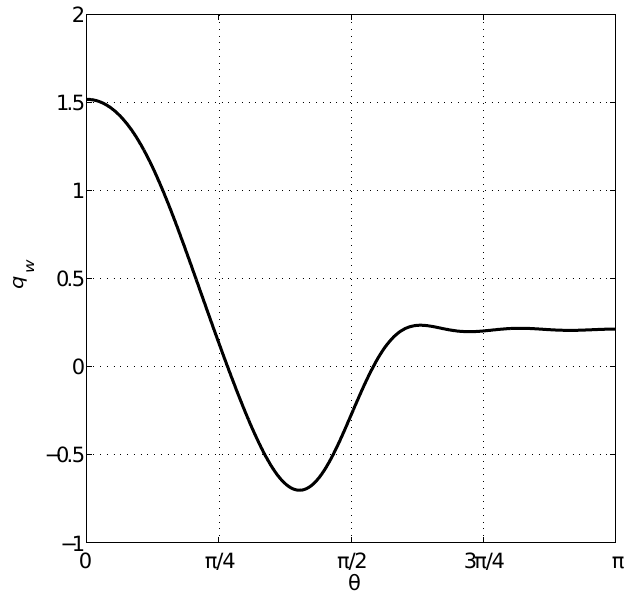
Figure 12. Hyperboloid of revolution under wind load. Wind pressure q w vs. circumferential angle θ .